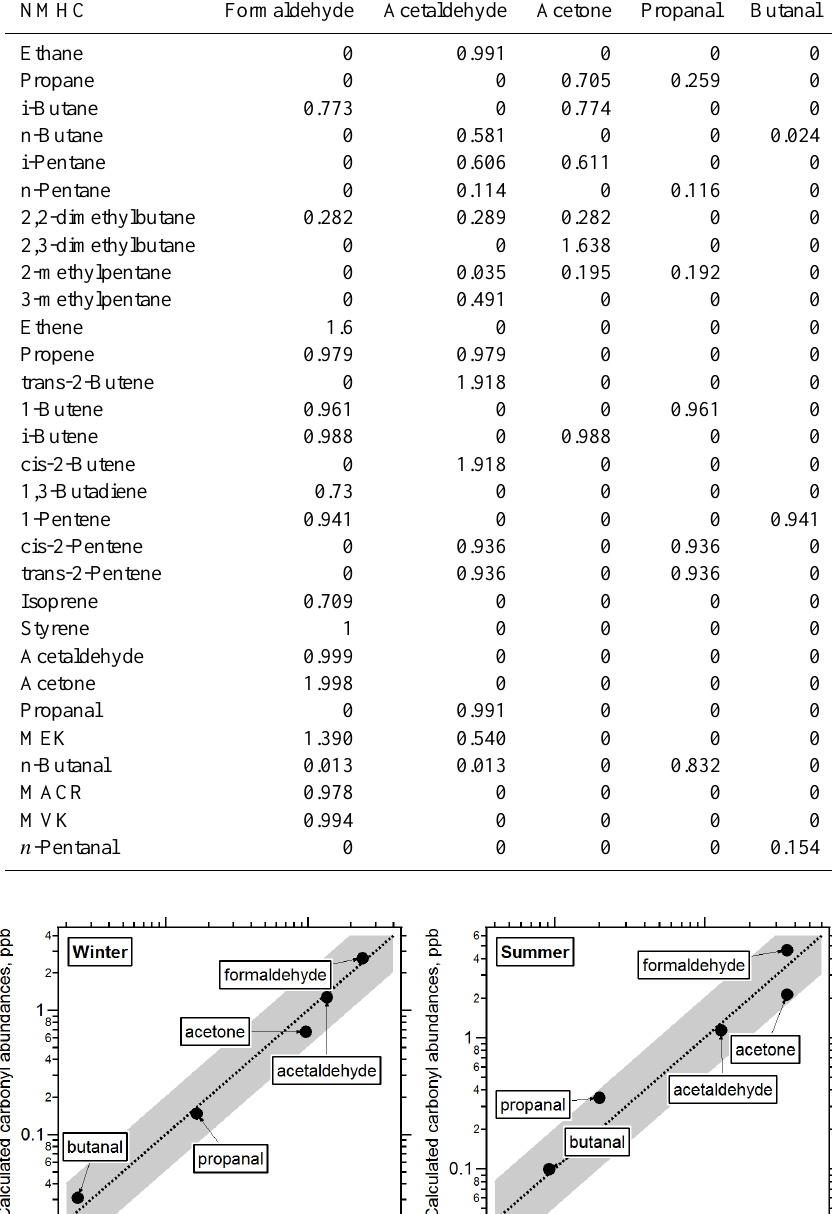
Table 2. Production yields of carbonyls from VOCs (unit: ppb/ppb) http://mcm.leeds.ac.uk/MCM/.